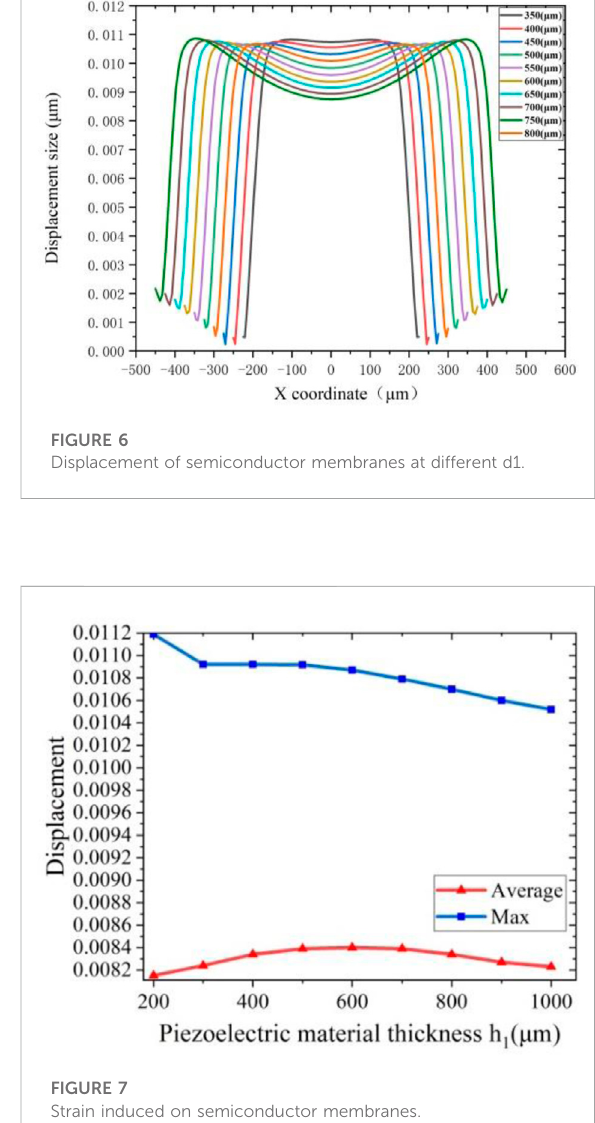
FIGURE 7 Strain induced on semiconductor membranes.